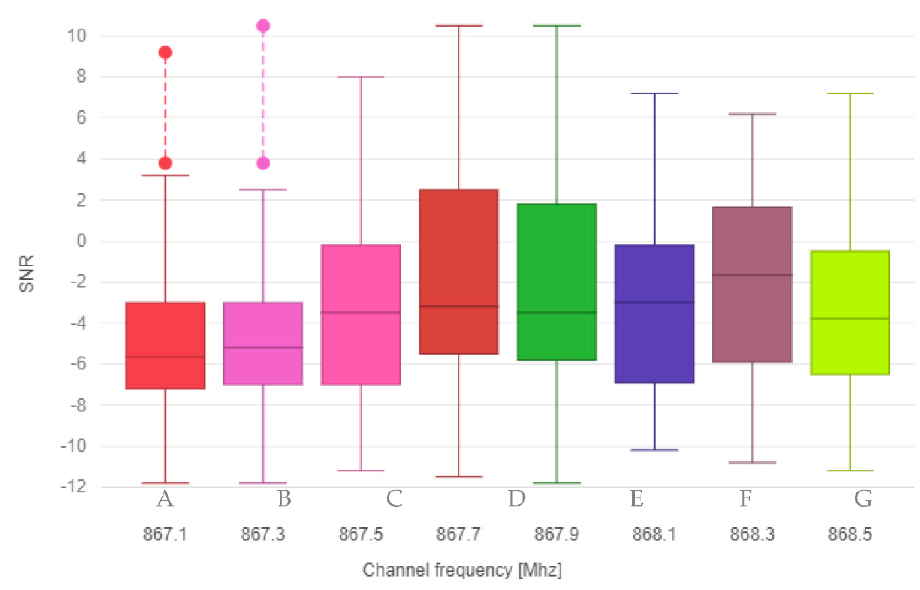
Figure 3. Boxplot graph for frequency channel and SNR.